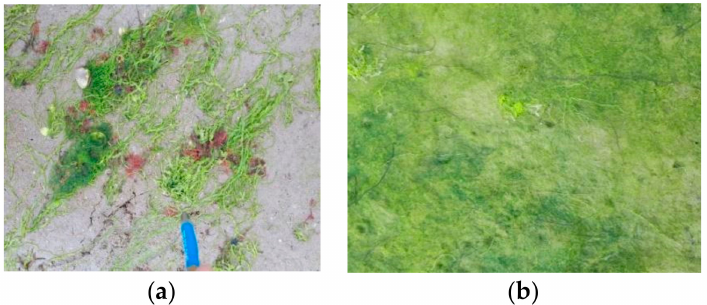
Figure 9. Macroalgae species associated with Z. noltei ( a ) and filamentous green macroalgae ( b ) in the mixed beds observed in the intertidal area of the Merja Zerga lagoon.